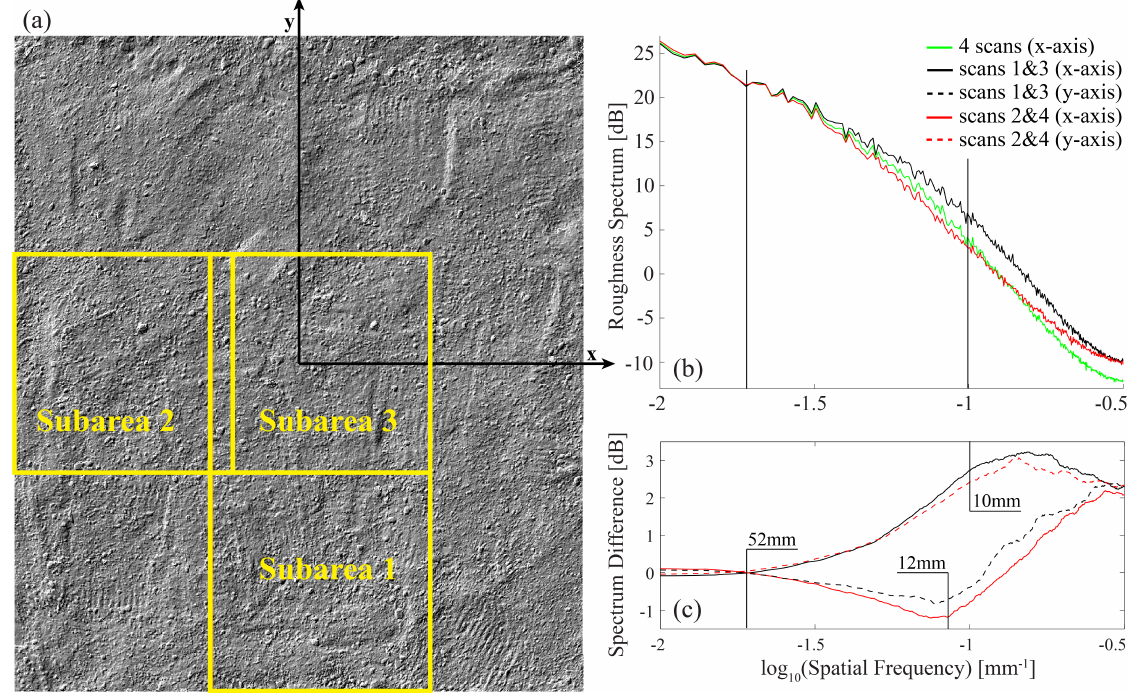
Figure 11. ( a ) Three subareas of the plot where the directional pattern was analyzed; ( b ) The roughness spectra of Subarea 3 estimated from the rows, i.e. , along the x-axis, of the three DEMs; ( c ) The differences of the roughness spectra with respect to the four-scan roughness spectrum, estimated along the x-axis (the full lines), as well as along the y-axis (dashed lines); The legend of the (b) is also valid for the